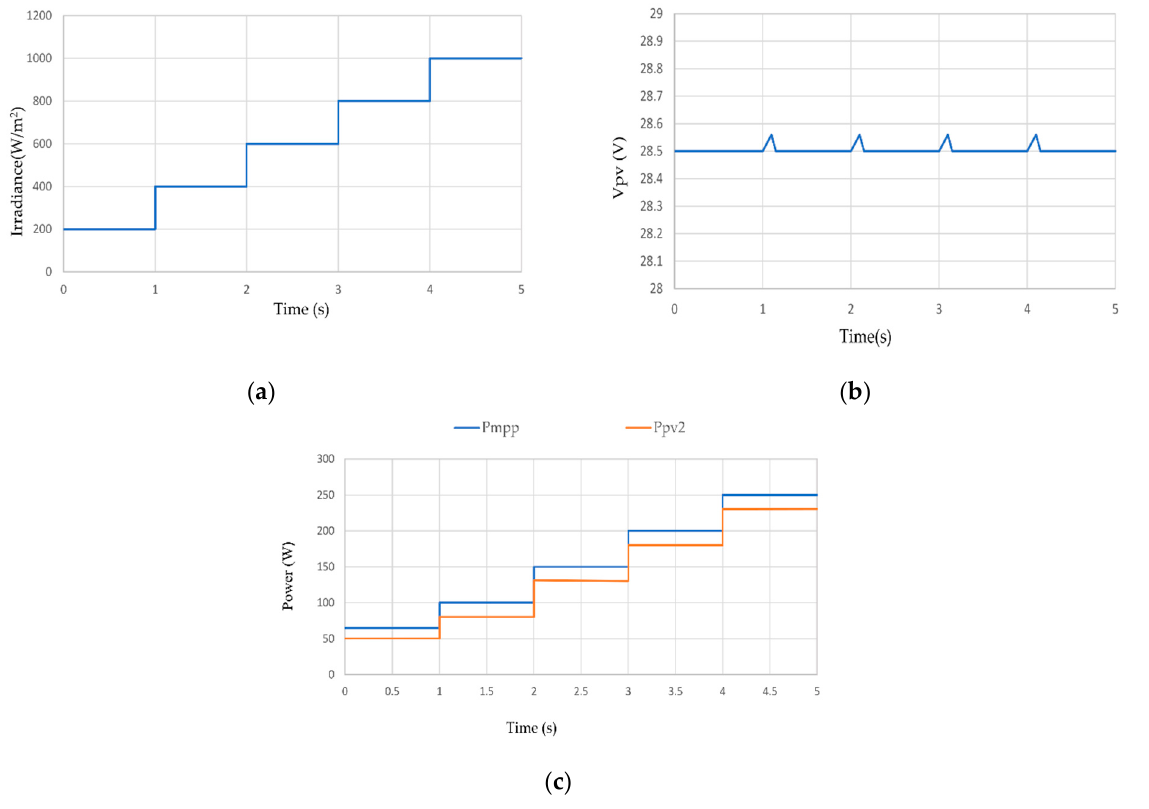
Figure 8. System output waveforms when ∆ P is fixed at 50 W and irradiance is varied from 200 W/m 2 to 1000 W/m 2 : ( a ) Irradiance; ( b ) PV output voltage; ( c ) PV output power. Case 3: Irradiance and power reserve ratio are both varied.